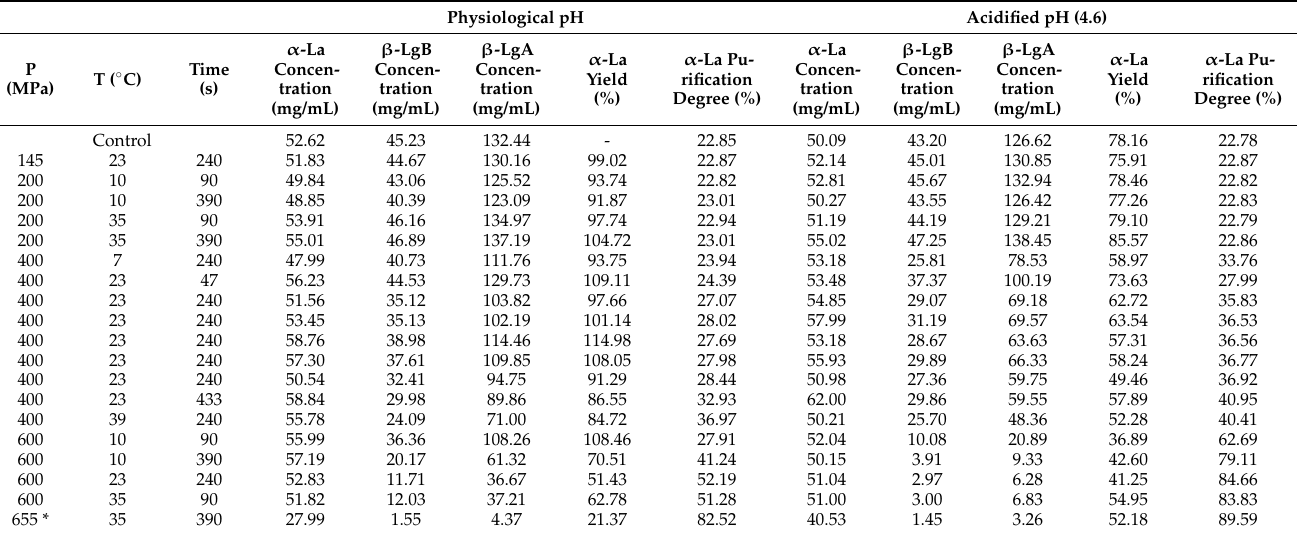
Table 2. First set of experiments. Protein concentrations and main process performance parame- ters of α -Lactalbumin ( α -La)-enriched fraction after high-pressure processing (HPP) (supernatant). * Processed 600 MPa for technical reasons. P = pressure; T = initial sample